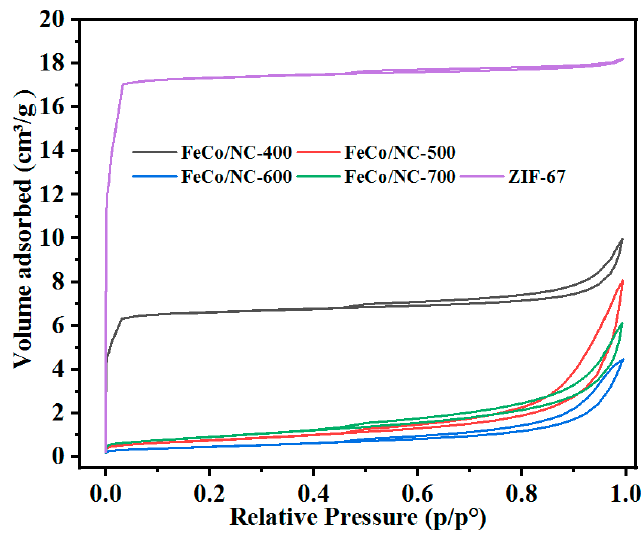
Figure 1. N 2 adsorption–desorption isotherms of FeCo/NC-T samples.